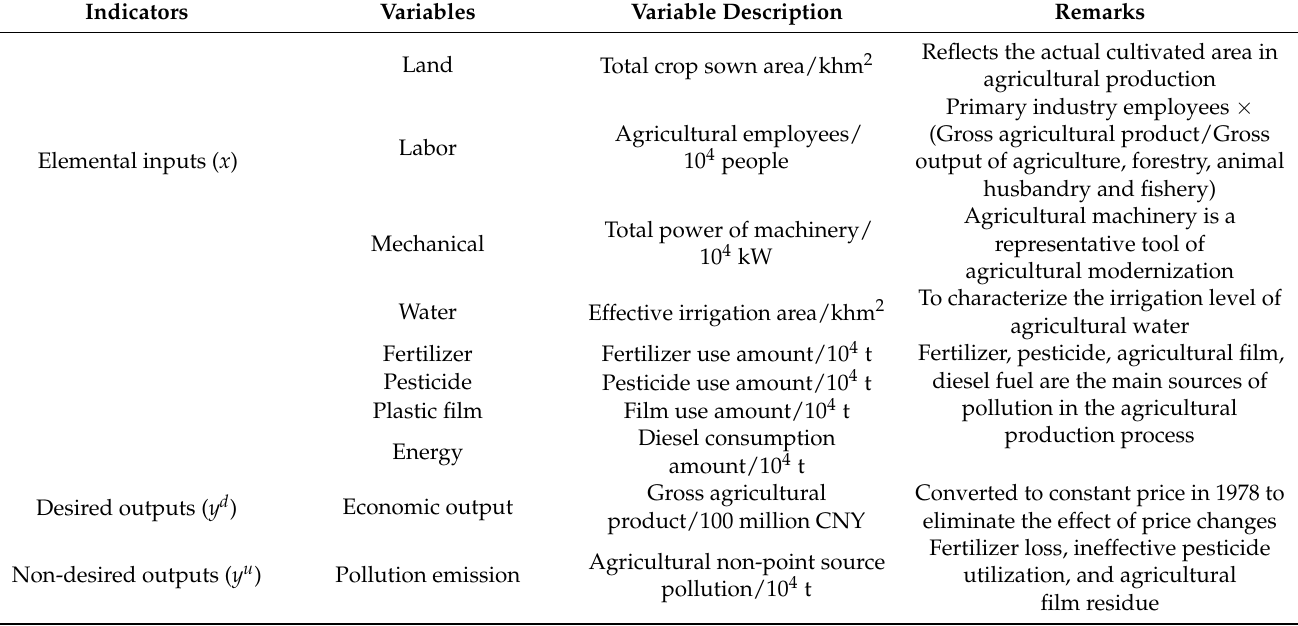
Table 1. Evaluation index system of